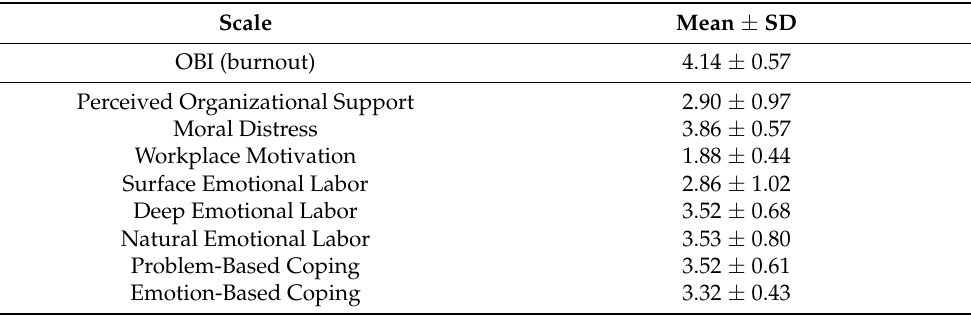
Table 1. Means and standard deviations of